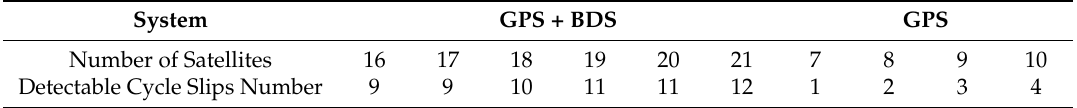
Table 1. The Detectable Cycle Slips Number for Different Number of Satellites. System GPS + BDS